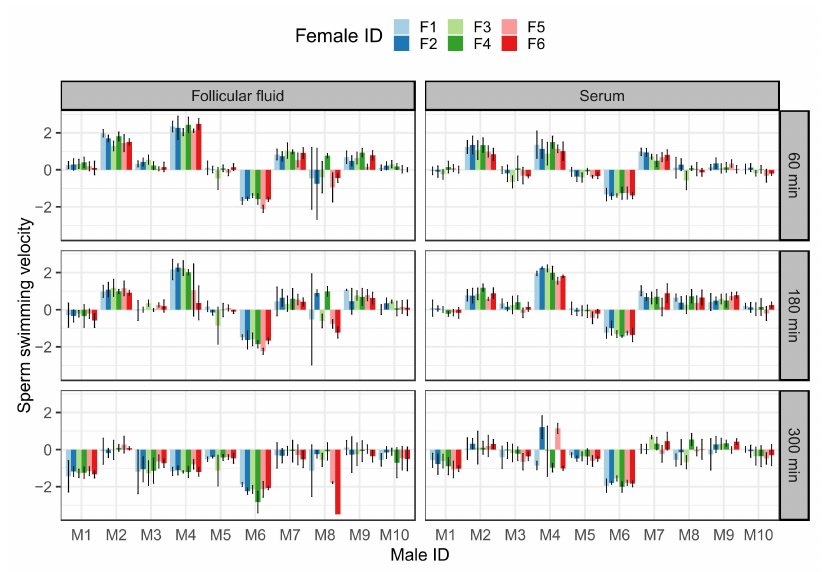
Figure 1. The effect of male:female interaction (combination) on the sperm swimming velocity (calculated on four replicate measurements per combination ± s.e.) at three different time points (60, 180, and 300 min) after the initiation of the follicular fluid or serum treatment. The data were standardized to a mean of 0 and a standard deviation of